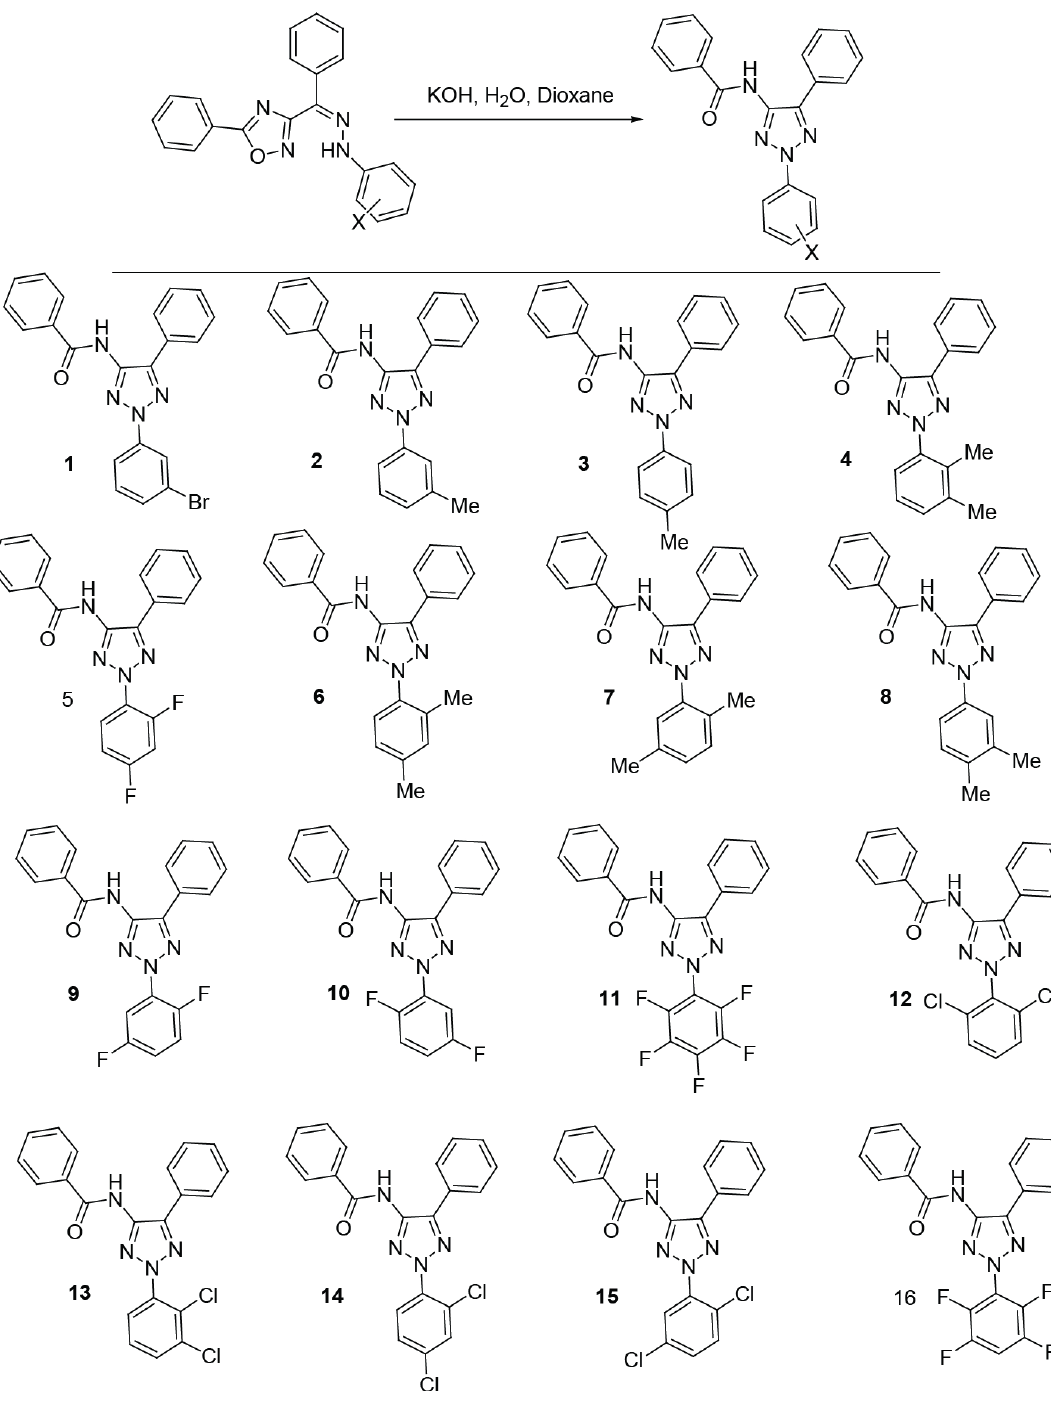
Figure 6 - examples of molecules obtained through the Boulton-Katritzky rearrangement of